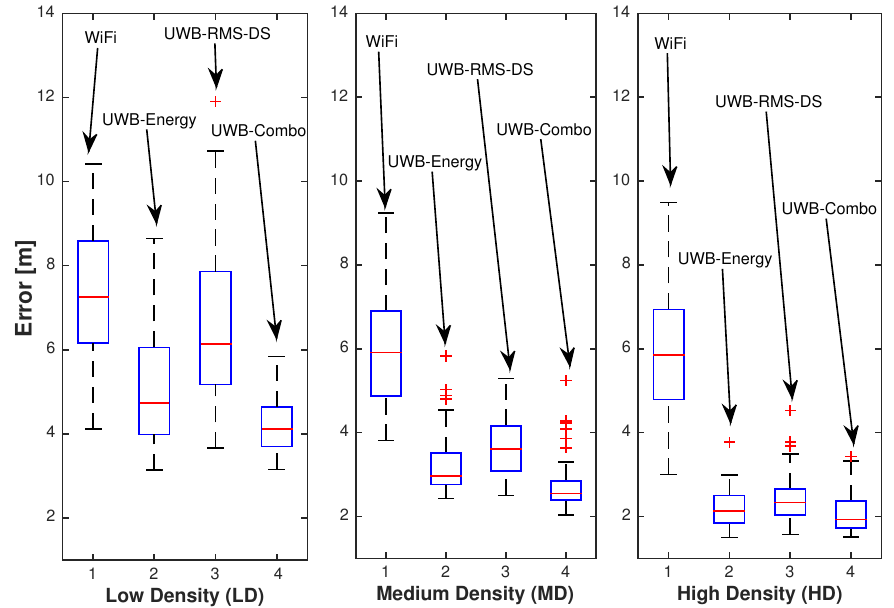
Figure 6. Statistics of positioning error (cid:101) in low, medium and high density (LD, MD and HD) scenarios for WiFi, ultra-wideband (UWB)-energy, UWB root-mean-square delay spread (RMS-DS) and UWB-combo with adaptive k -nearest neighbor ( k NN)